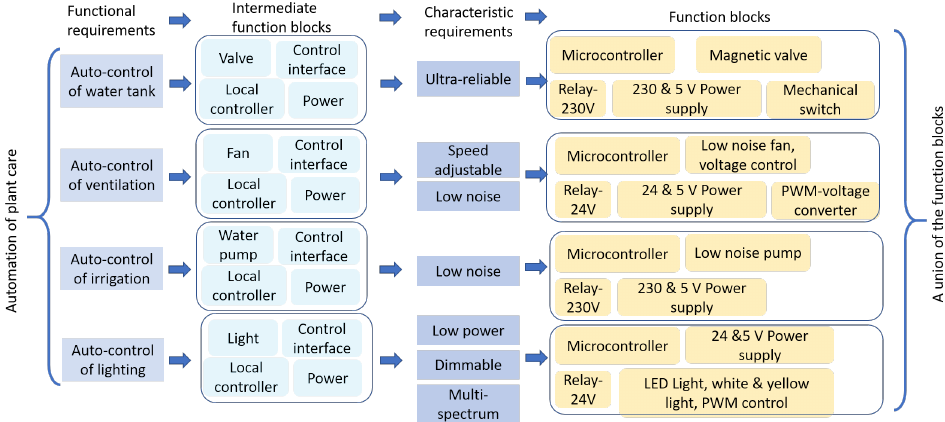
Figure 5. The automation of plant care feature extracted from the business stage is taken as input to the technology stage and translated into a union of function blocks that define needed components to achieve the